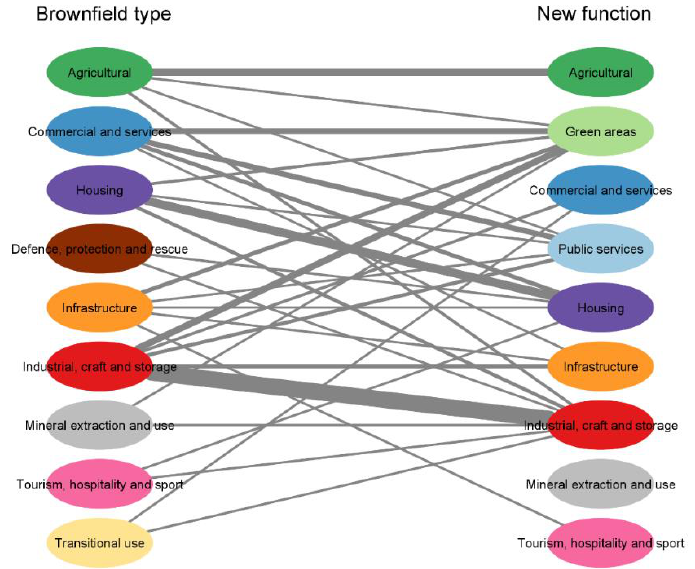
Figure 7. The currents of changes — brownfields regeneration in the Moravian-Silesian region (2017 – 2022). Line thickness indicating the number of changes. Based on [26,27]. Prepared by the authors.